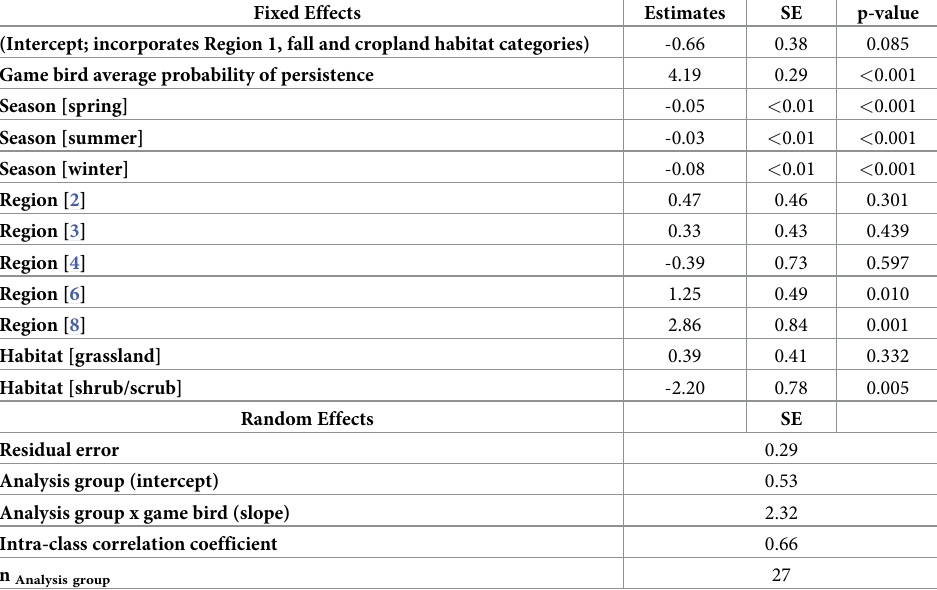
Table 4. Parameter estimates for best supported (AICc) linear mixed-effects model of raptor average probability of persistence as a function of game bird average probability of